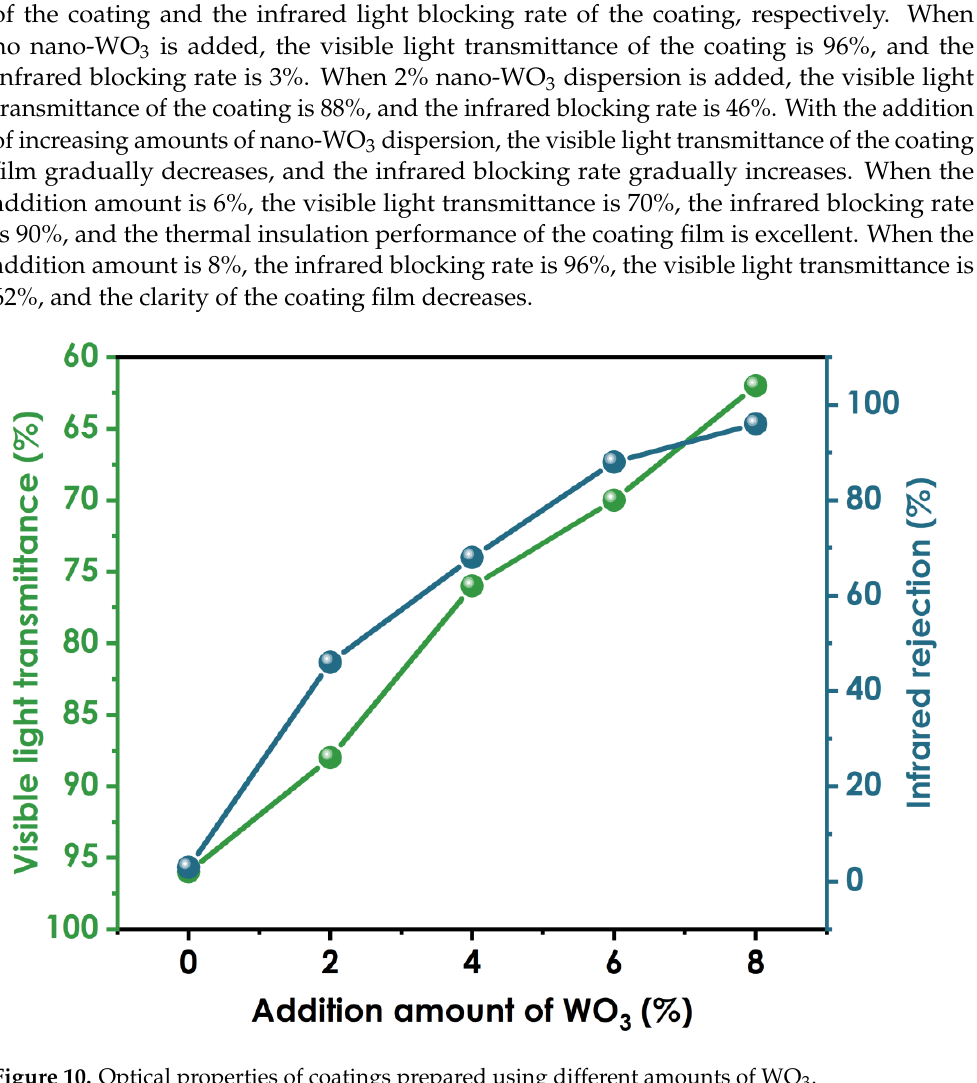
Figure 10. Optical properties of coatings prepared using different amounts of WO